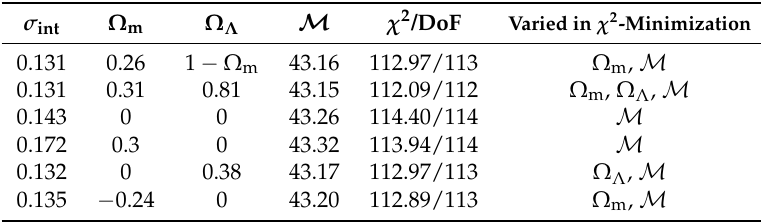
Table 2. Different possible Λ CDM models which provide χ 2 /DoF ≈ 1 for suitably chosen σ int to fit 115 SNeIa from Astier et al. [15].